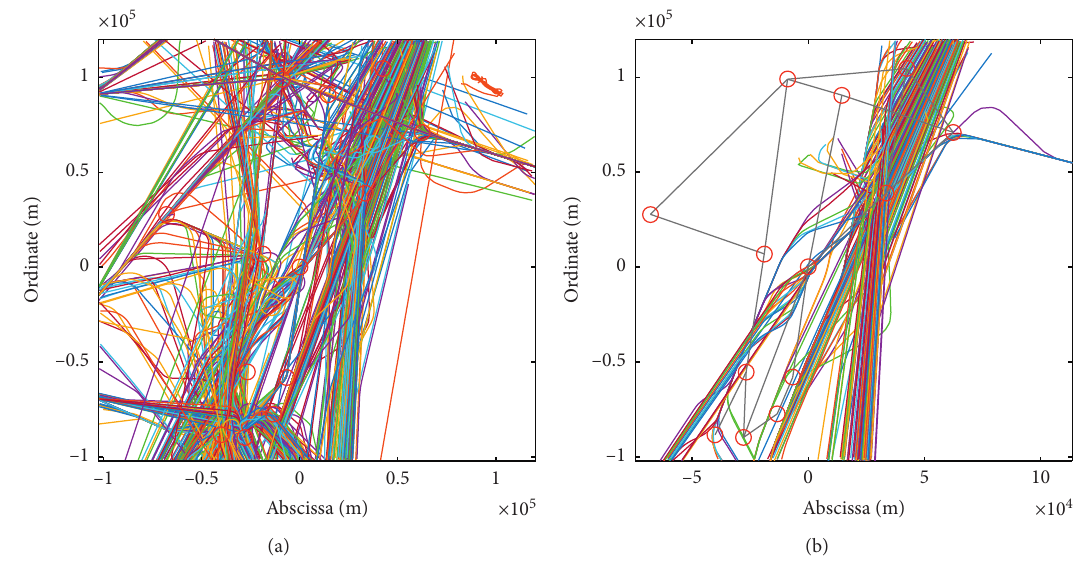
Figure 5: Traffic flow through P449 extracted on December 14, 2019. (a) All traffic flows over Laiyang on December 14, 2019. (b) Traffic flow through P449 extracted on December 14,